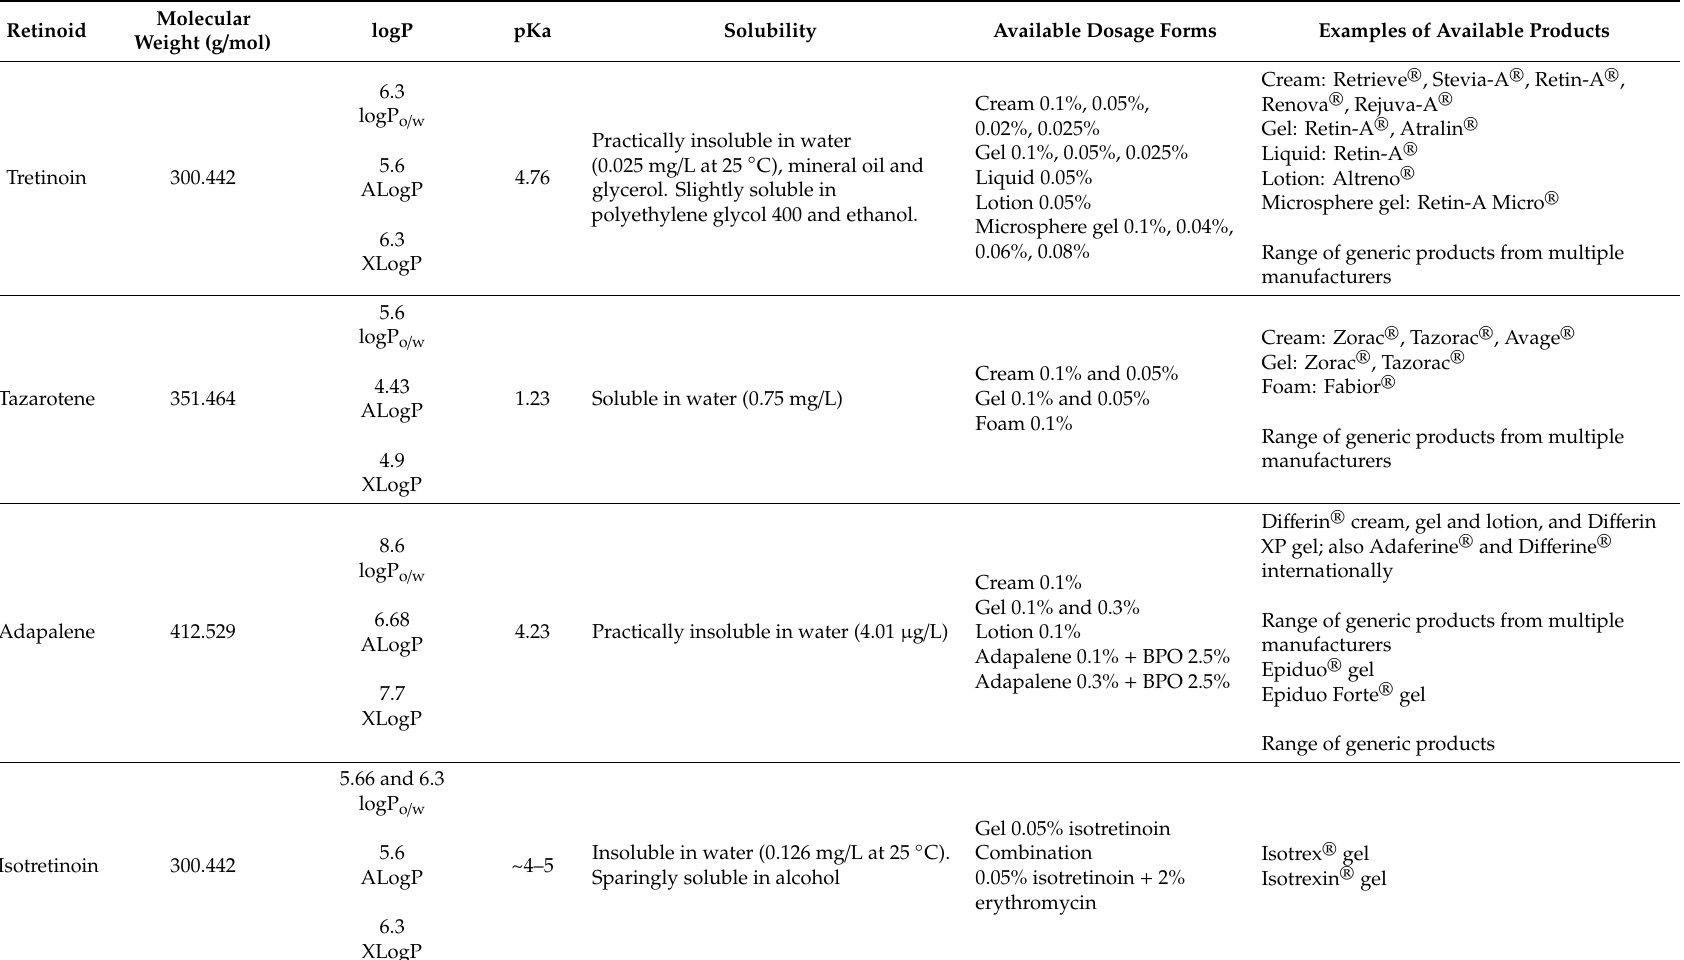
Table 2. Physicochemical data, topical dosage forms and products for retinoid drugs sourced from [23–27]. Retinoid Available Dosage Forms Examples of Available Products